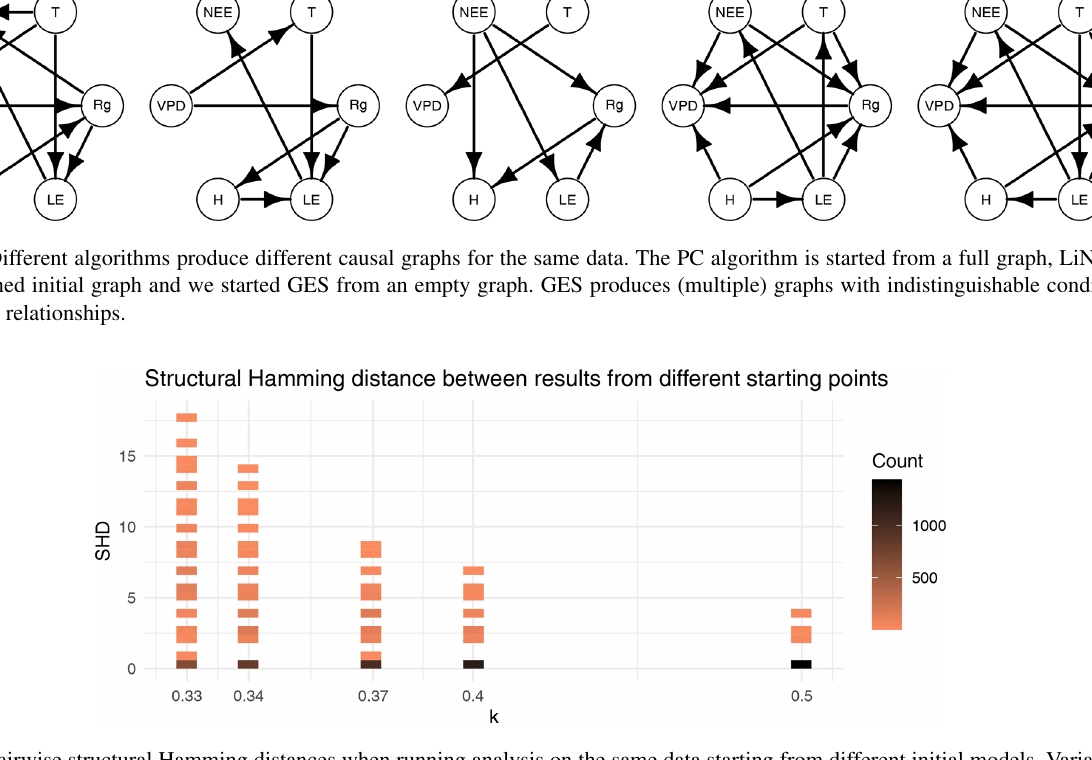
Figure 2. Pairwise structural Hamming distances when running analysis on the same data starting from different initial models. Variance in the distances shows that the final model is affected by the choice of initial model. Additionally, the spread of distances decreases rapidly with increasing prior